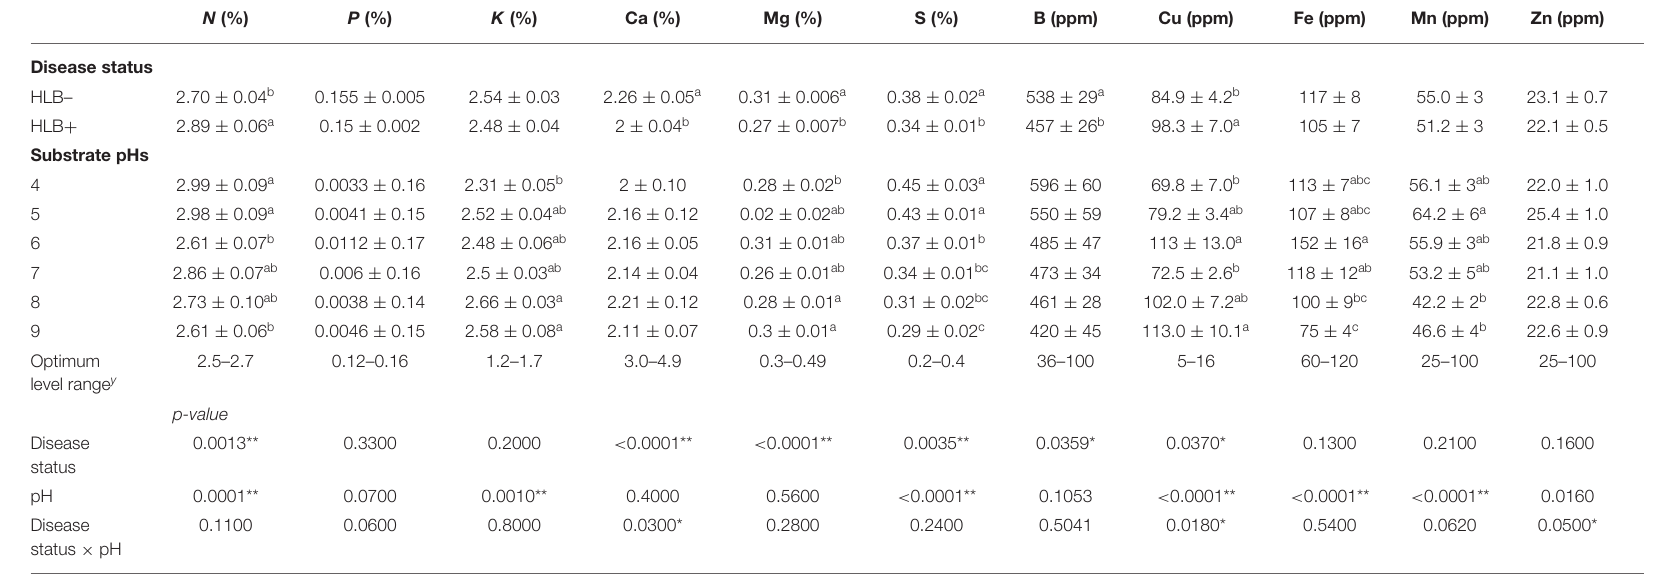
TABLE 2 | Leaf mineral nutrient concentration of “Ray Ruby” grapefruit ( C. paradisi ) on sour orange ( C. aurantium ) rootstock exposed to different HLB disease statuses [HLB-free or healthy (negative, HLB–) and HLB-affected (positive, HLB + )] under an increasing range of substrate pHs (4–9) at 90